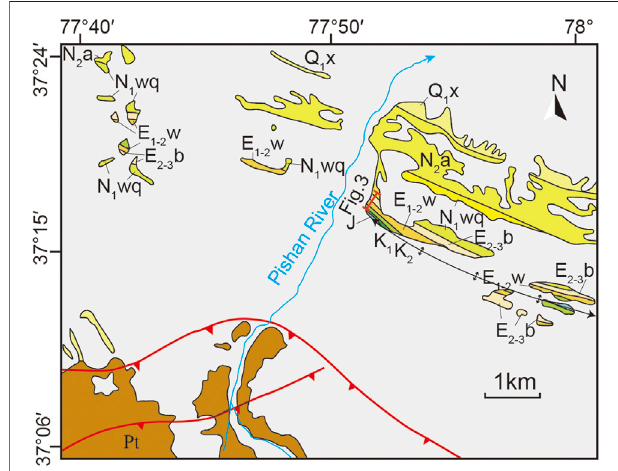
FIGURE 2 | Geological sketch map of the Keliyang area in the SW Tarim Basin (modi fi ed after Shaanxi Geological Bureau, 2006). Q 1x , Xiyu Formation; N 2a , Artushi Formation; E 2-3b , Bashiibulake Formation; E 1-2W , Aertashi- Qimugen-Kalatar-Wulagen Formations; K 2 , Upper Cretaceous; K 1 , Lower Cretaceous; J, Jurassic; Pt, Paleozoic.